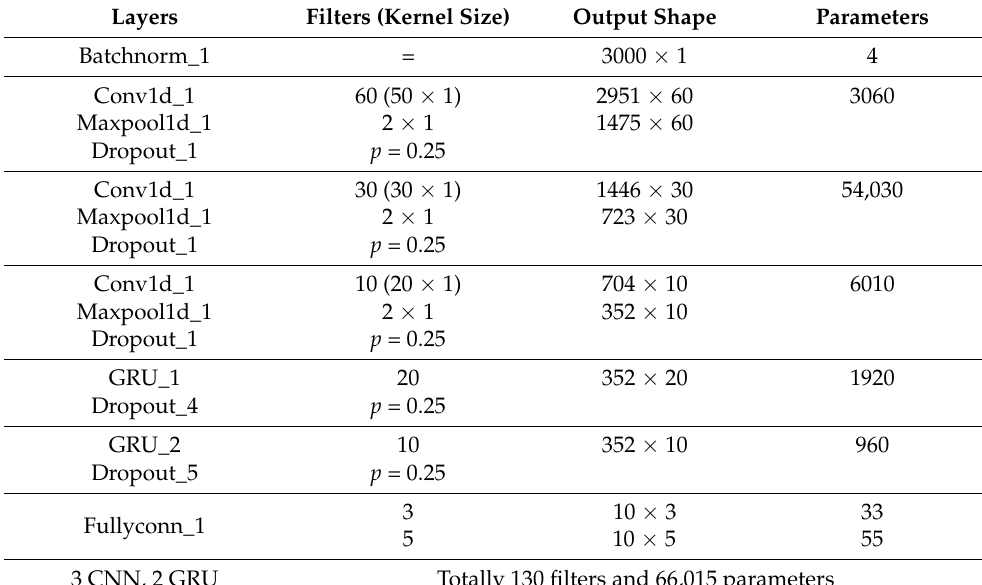
Table 2. Detailed architecture of the constructed DCR